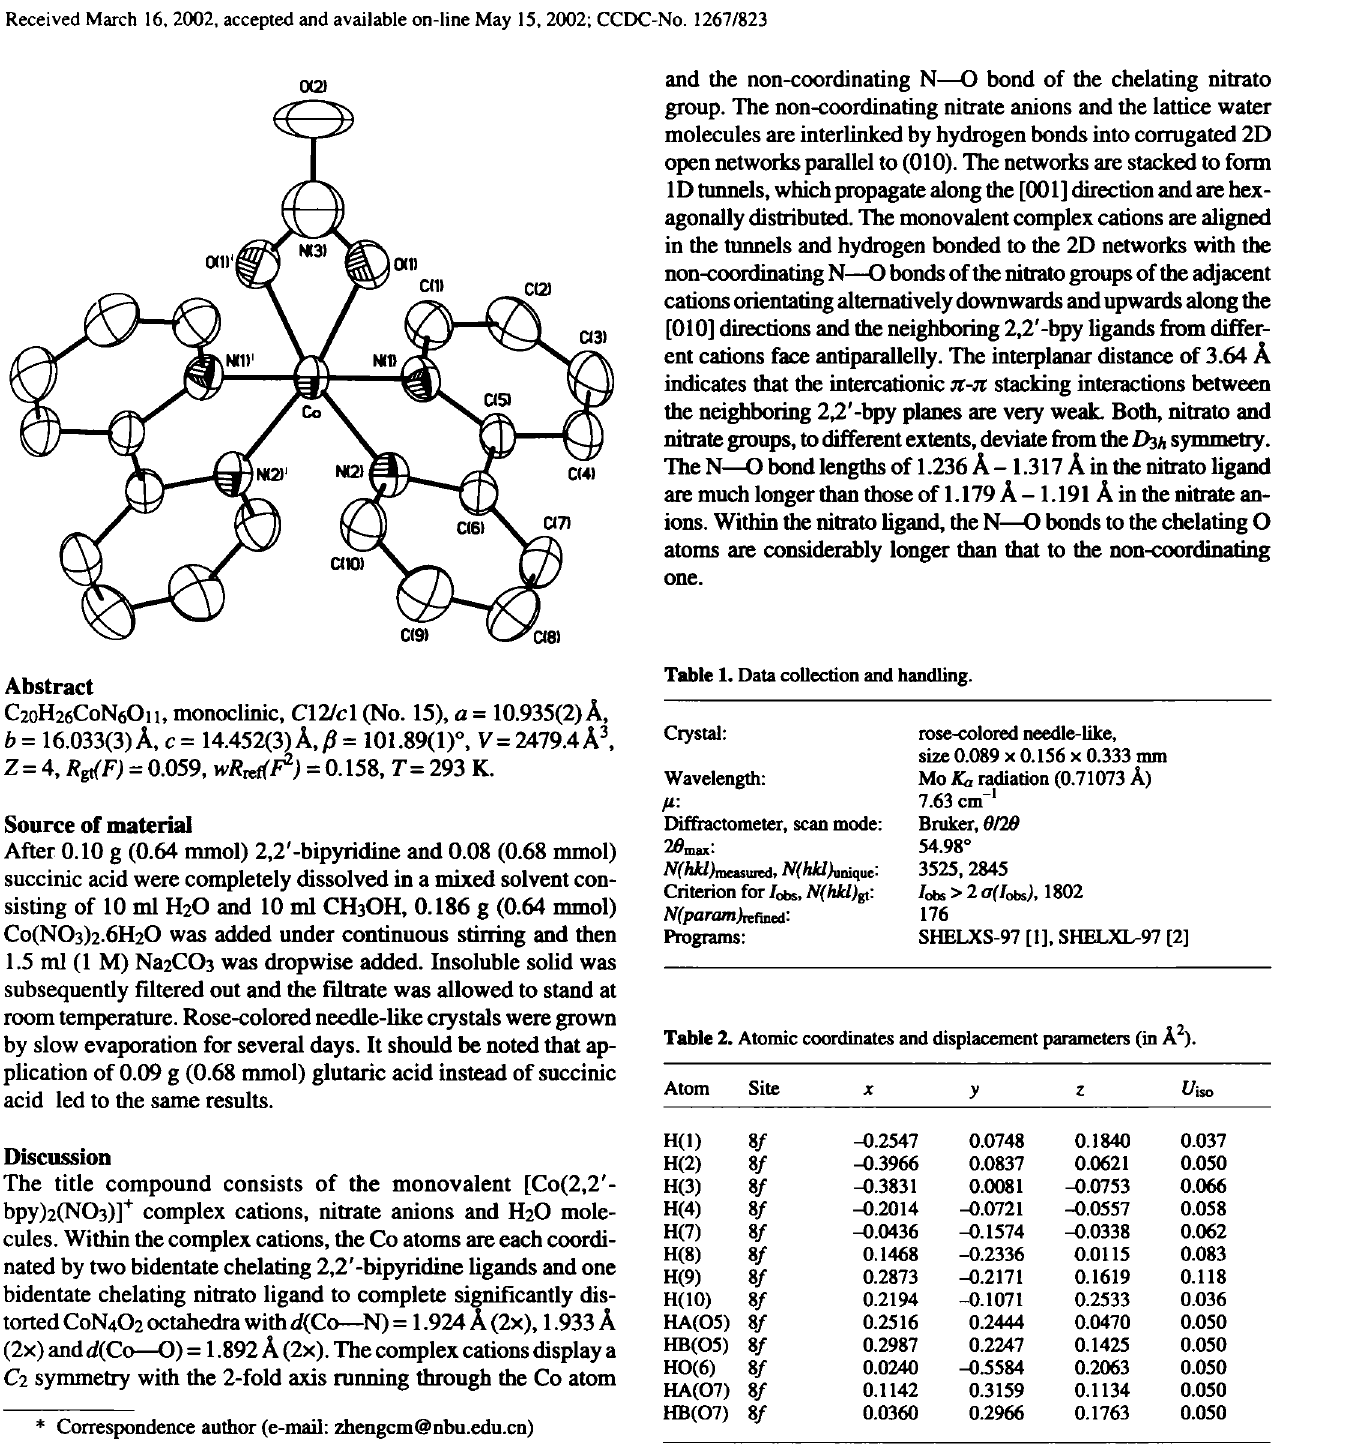
Table 2. Atomic coordinates and displacement parameters (in Â 2